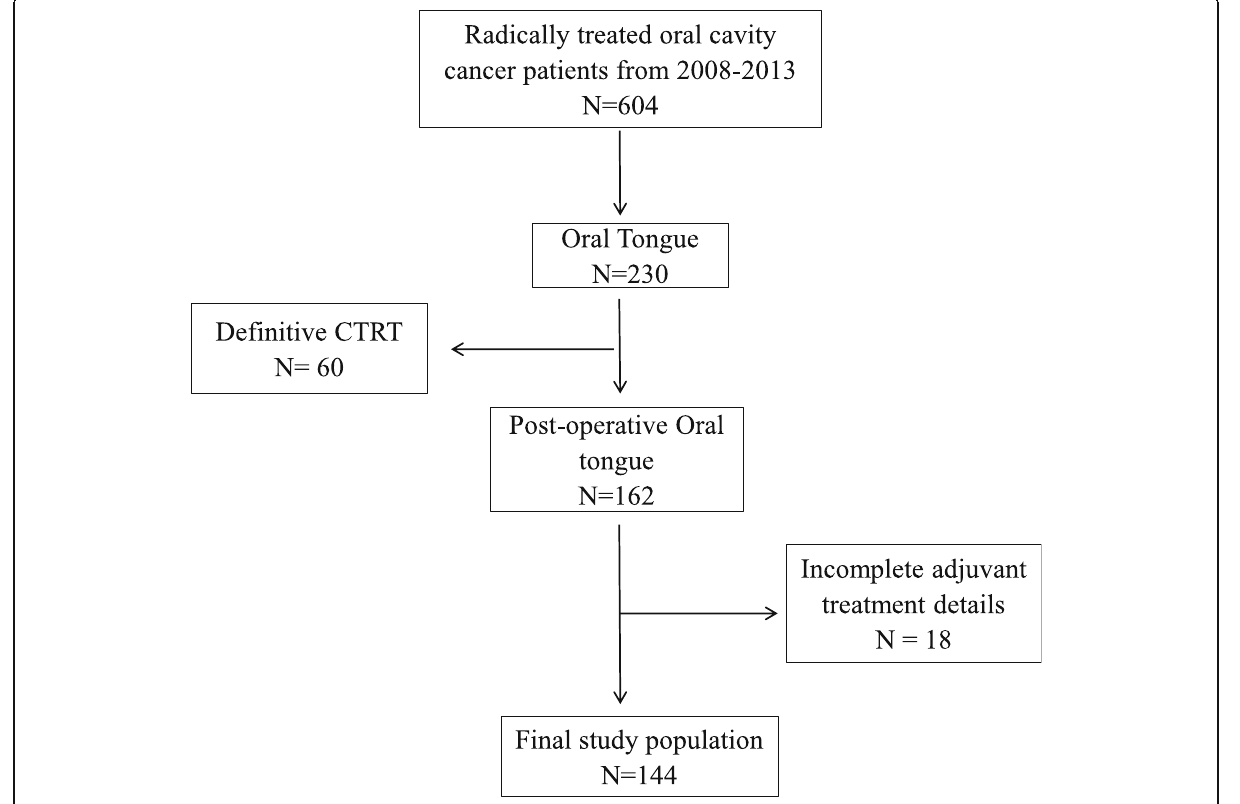
Fig. 1 Consort diagram of the carcinoma oral tongue